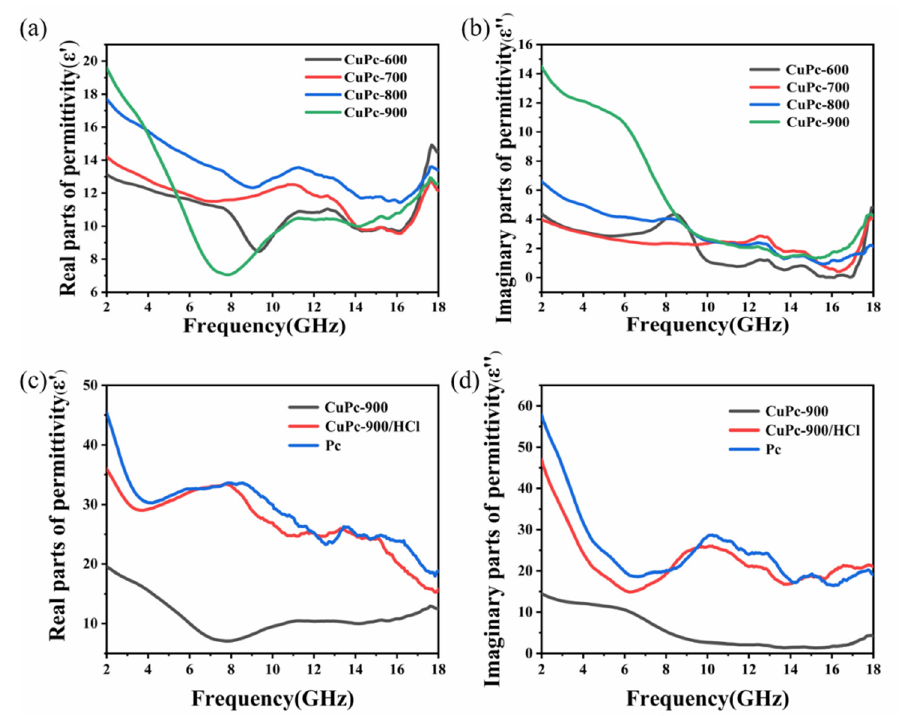
Figure 5. Comparison graph of dielectric constants of copper phthalocyanine carbon nanosheets. ( a , c ) Real parts of permittivity and ( b , d ) imaginary parts of permittivity. The reflection loss ( R L ) is broadly used to evaluate the EMW absorption